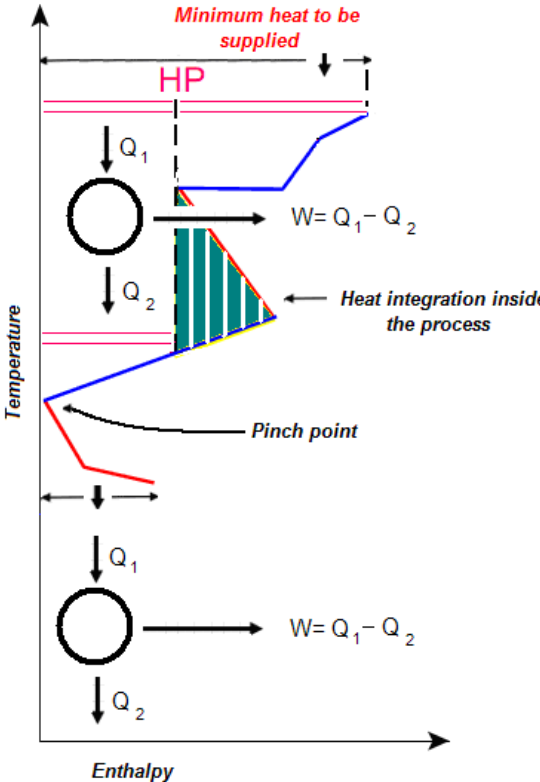
Figure 8. Cogeneration above and below the